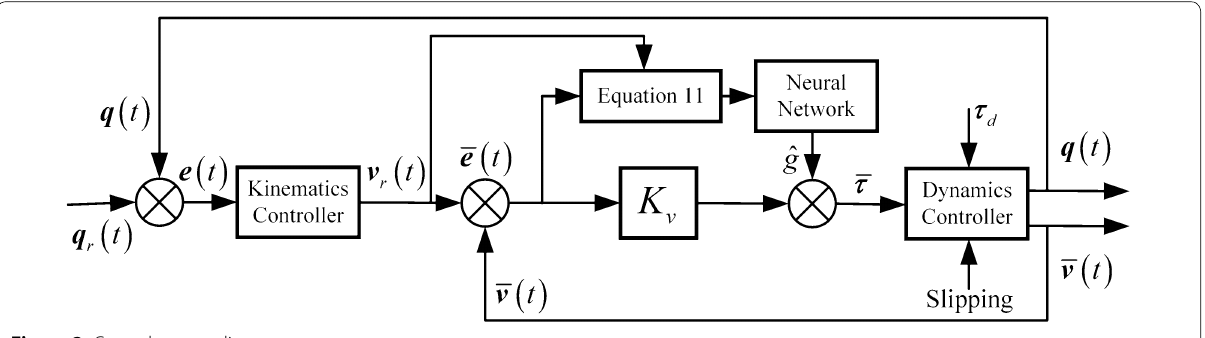
Figure 2 Control system diagram